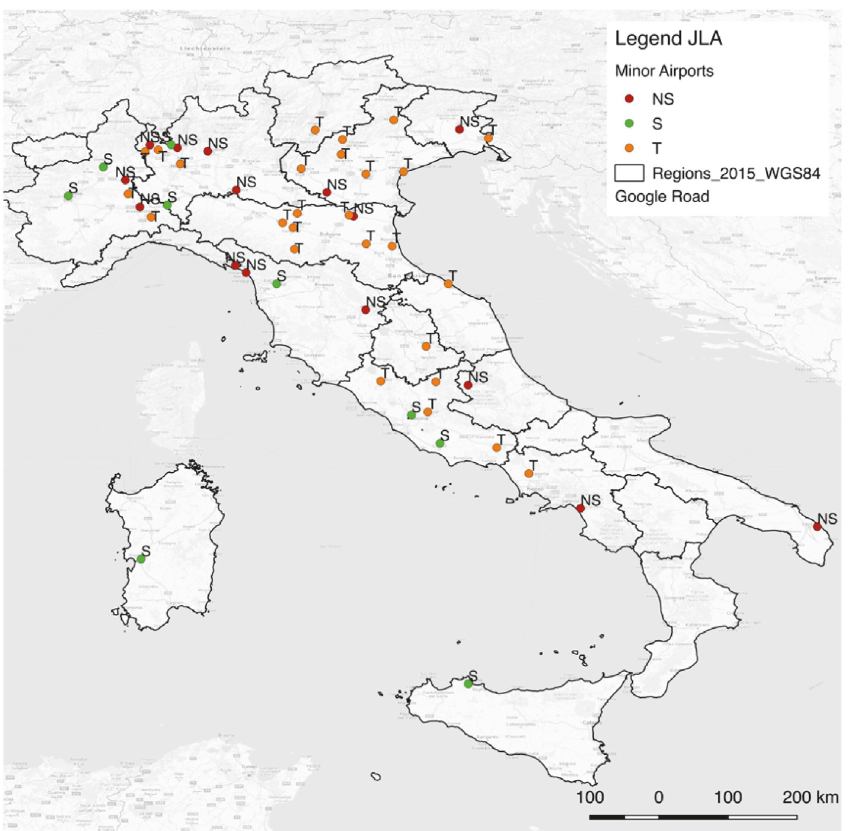
Figure 6: MCSDA implementation for JLA: spatial